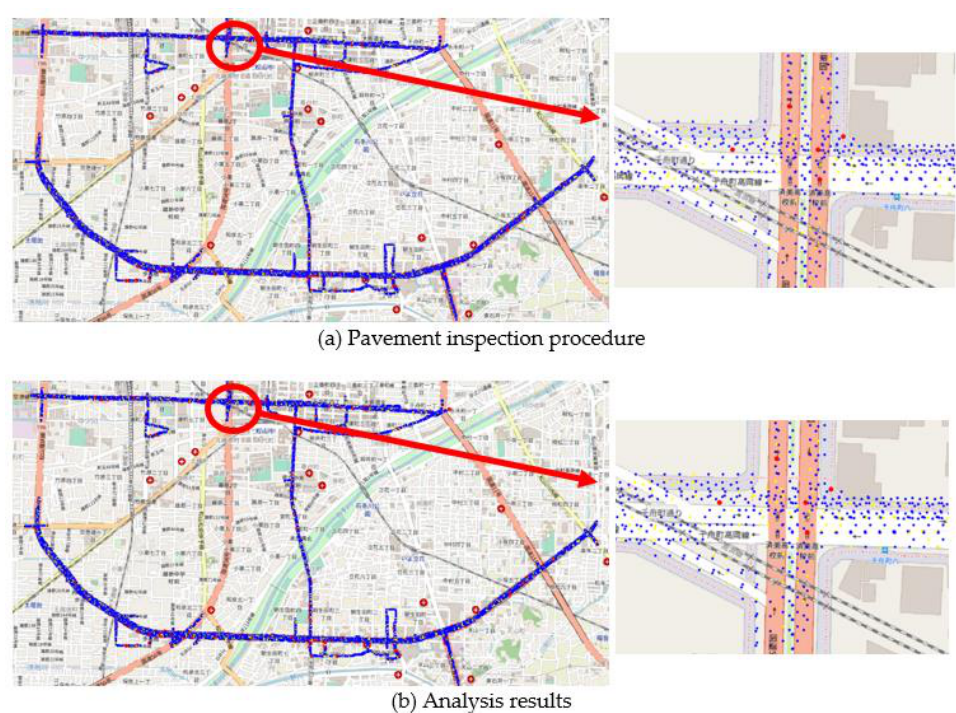
Figure 12. Comparison of pavement inspection procedure and analysis results on GIS.